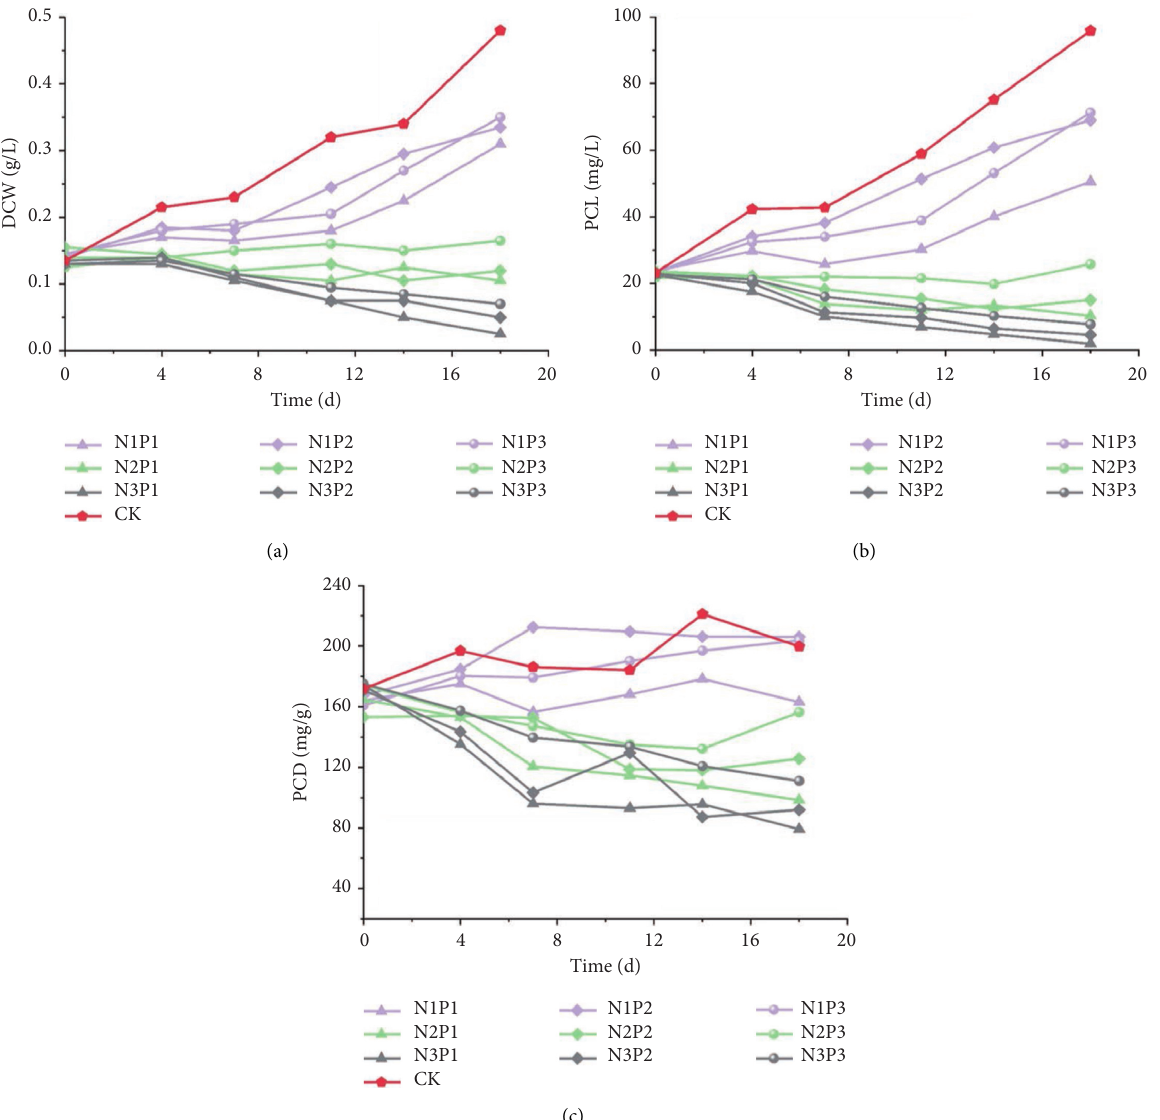
Figure 4: Change process of (a) dry cell weight (DCW), (b) the content of phycocyanin in liquid (PCL), and (c) the content of phycocyanin in dry Spirulina (PCD). The CK is the control group, using Spirulina medium with 2.5 g/L concentration of NaNO 3 and 0.5g/L K 2 HPO 4 . The experimental group consists of different concentrations of NH 4 Cl (N1, 0.1 g/L; N2, 0.2g/L; N3, 0.3g/L) and K 2 HPO 4 (P1, 0.02g/L; P2, 0.42g/L; P3,